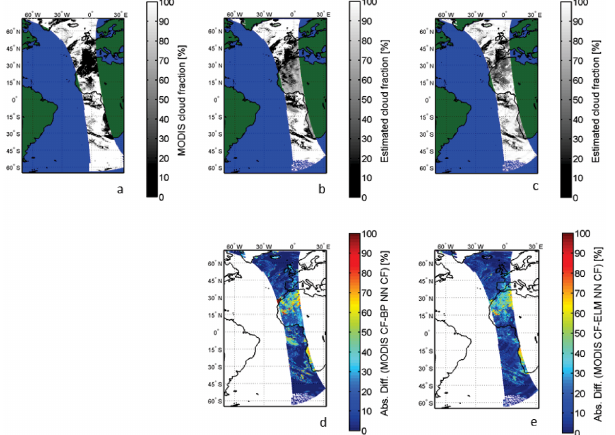
Fig. 7. Cloud fractions estimated by the BP and ELM-trained NN and comparison with MODIS CF data for the validation orbit 2006m0912t0828. (a) Computed MODIS geometrical cloud frac- tion re-located onto the OMI grid. (b) BP predicted cloud fraction. (c) ELM predicted cloud fraction The grey-code in (a–c) ranges from 0 (cloud free) to 100 (totally cloud covered). (d) Absolute difference between MODIS geometrical cloud fraction and BP- predicted cloud fraction. The color-code ranges from 0 (perfect match) to 100 (complete mismatch). (e) Absolute difference be- tween MODIS geometrical cloud fraction and ELM-predicted cloud fraction. The color-code in panels (d) and (e) range from 0 (perfect match) to 100 (complete